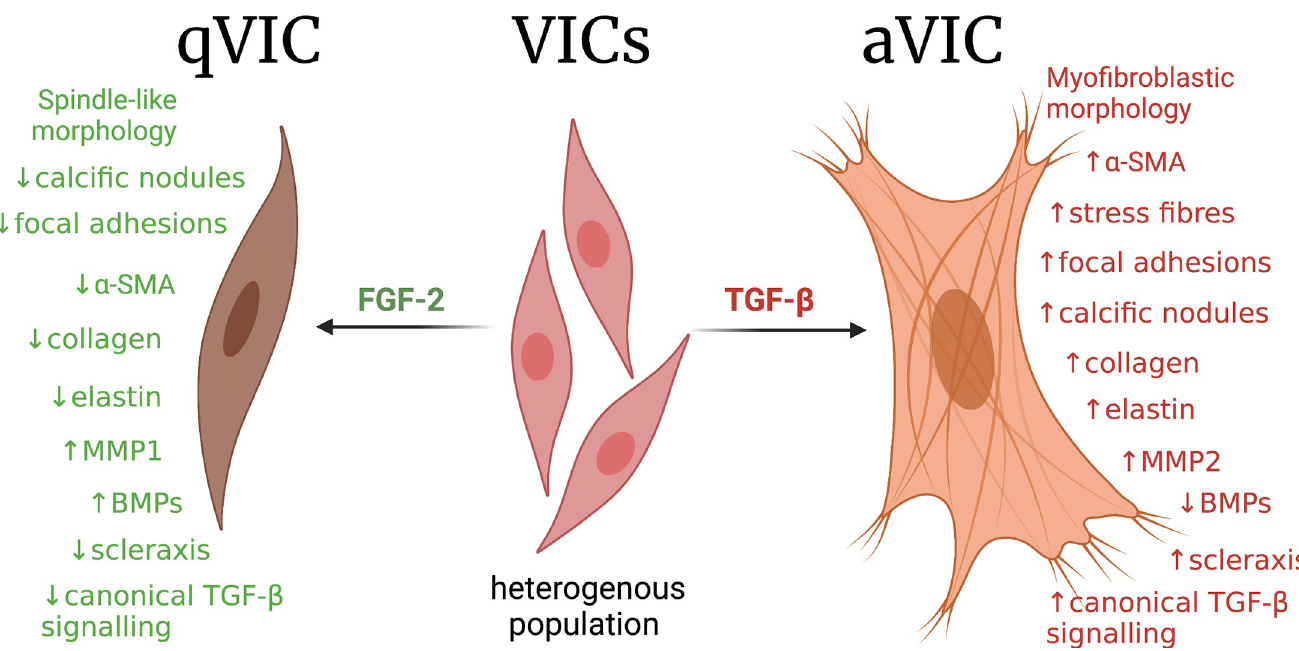
Fig 12. Summary of